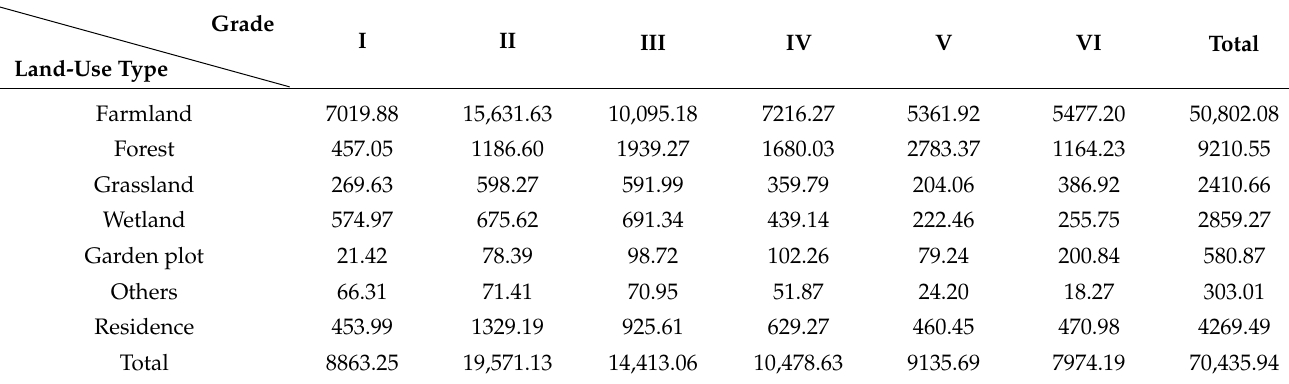
Table 5. The area of different land-use type in different soil-quality grade.